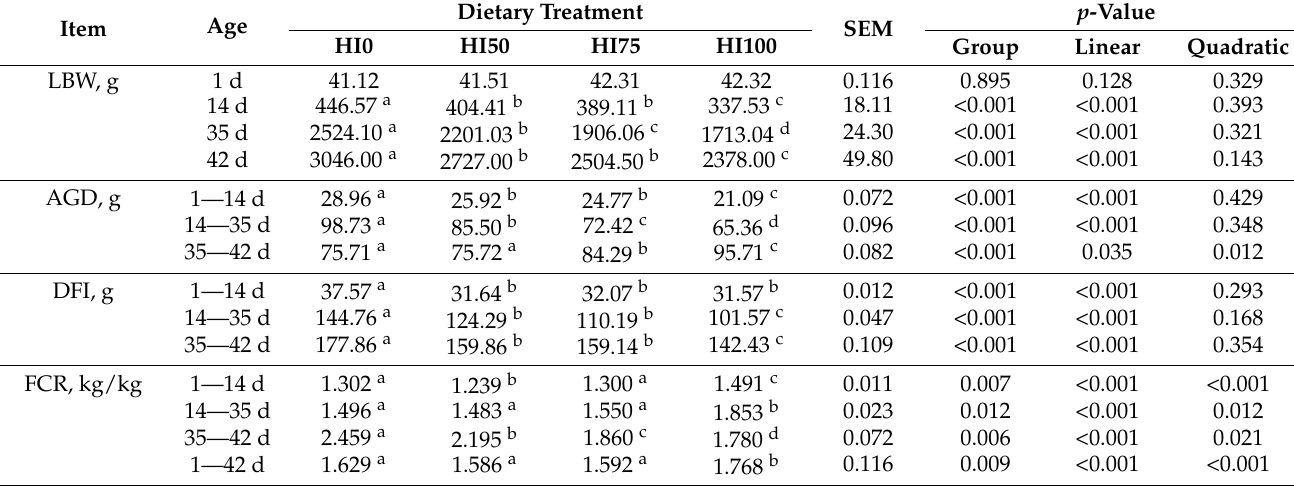
Table 3. Live body weight (LBW), average daily gain (ADG), daily feed intake (DFI) and the feed conversion ratio (FCR) in broiler chickens fed diets with different levels of full-fat Hermetia illucens (HI) larvae meal 1 (arithmetic mean, SEM, n = 8) 2